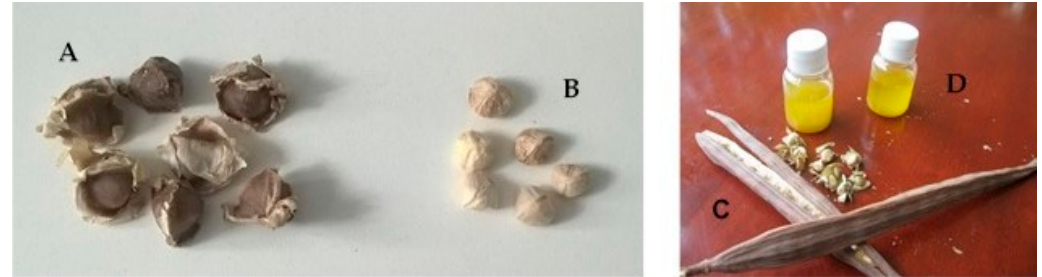
Figure 1. Seeds ( A ), kernels ( B ), fruits ( C ) and oil ( D ) of Moringa oleifera. Table 1. Chemical composition of Moringa oleifera seeds (g/100 g of dry weight). Nutrients Moringa oleifera